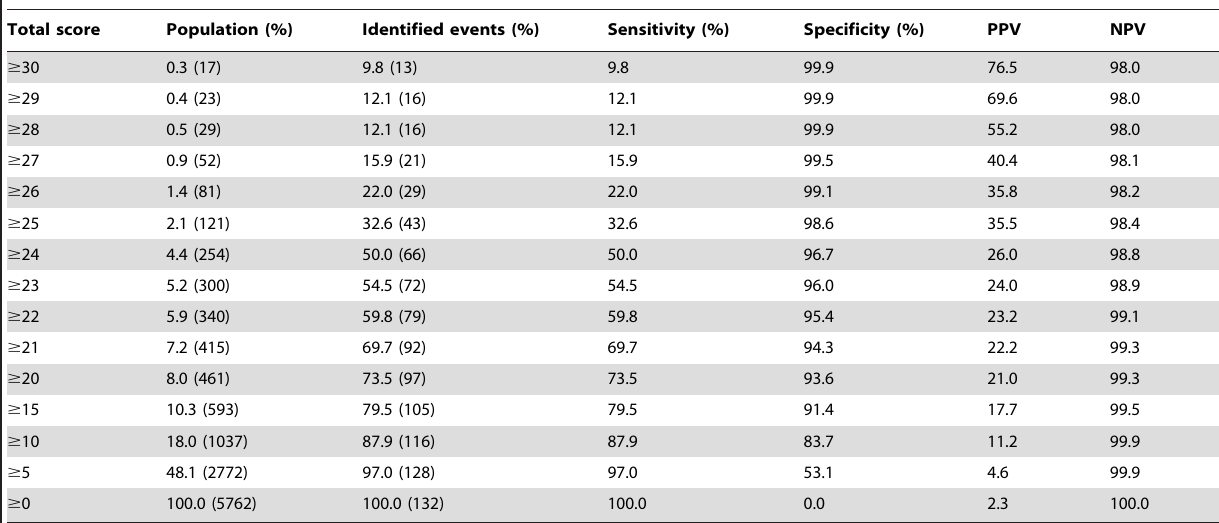
Table 6. Diagnostic characteristics of the prediction